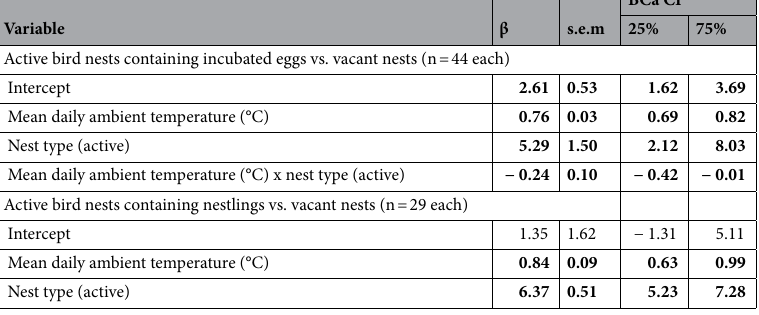
Table 1. Results of bootstrapped (2000 replications) linear regressions showing the changes of mean daily internal temperature (response variable) with the covariates of respective ambient temperature and nest type: active (occupied) and vacant (inactive) nests of wood warblers Phylloscopus sibilatrix in the Białowieża National Park (Poland). Compared are active nests that contained incubated eggs, or nestlings of a median 7 days old, and the same nests when vacant (post-fledging or nest failure). Including the interaction term visibly improved the model fit only for the incubation stage (L = 7.1, df = 1, P = 0.008). The statistically significant results are highlighted with bold font. Bias-corrected and accelerated bootstrap confidence intervals (BCa CI) are shown.